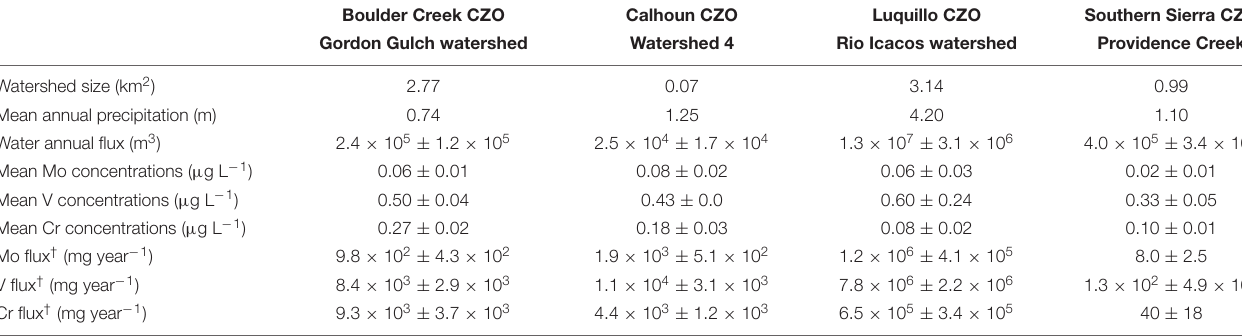
TABLE 3 | Stream water export estimates for dissolved Mo, V, and Cr across the four